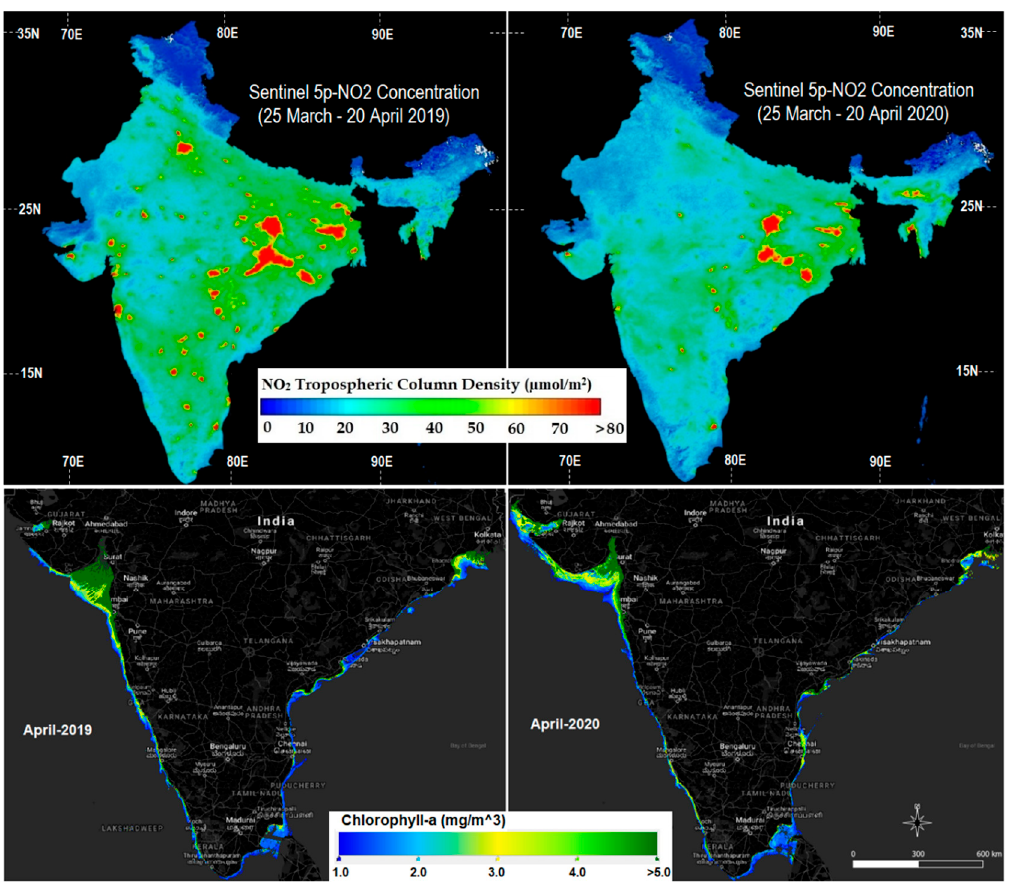
Figure 1. (Top) NO 2 concentration over India captured by the European Space Agency’s TROPOspheric Monitoring Instrument (TROPOMI) instrument on the Copernicus Sentinel-5P satellite. (Bottom) Comparison of chlorophyll-a levels between April 2019 and April 2020 in the coastal waters of India. Note: the mapped area is not the same in both years due to the differences in extent of cloud cover.